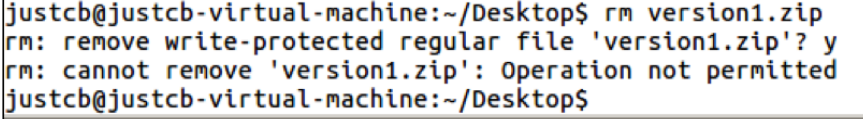
Figure 5. The file is immutable when trying to write or